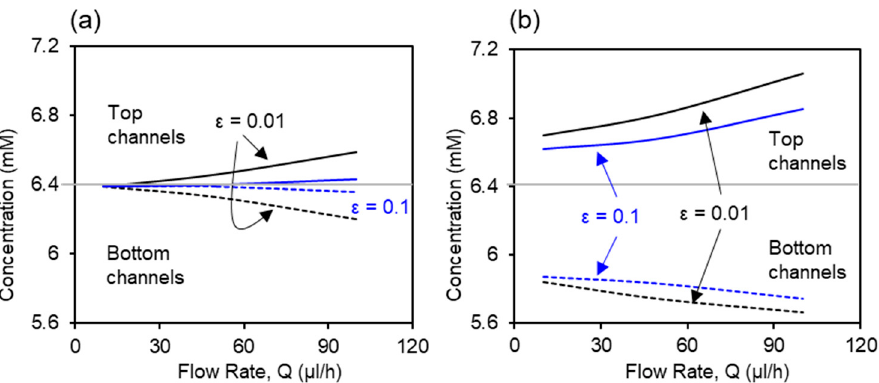
Figure 5. Effects of membrane porosity on the glucose transport in ( a ) bare membrane model and ( b ) co-culture model. Solid curves represent the glucose concentration in the top channels and dashed lines represent the glucose concentration in bottom channels.